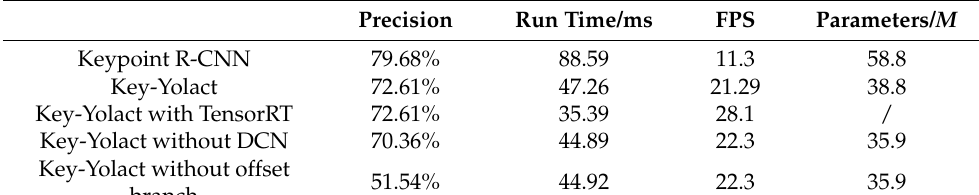
Table 2. Contrast and ablation experiment results.